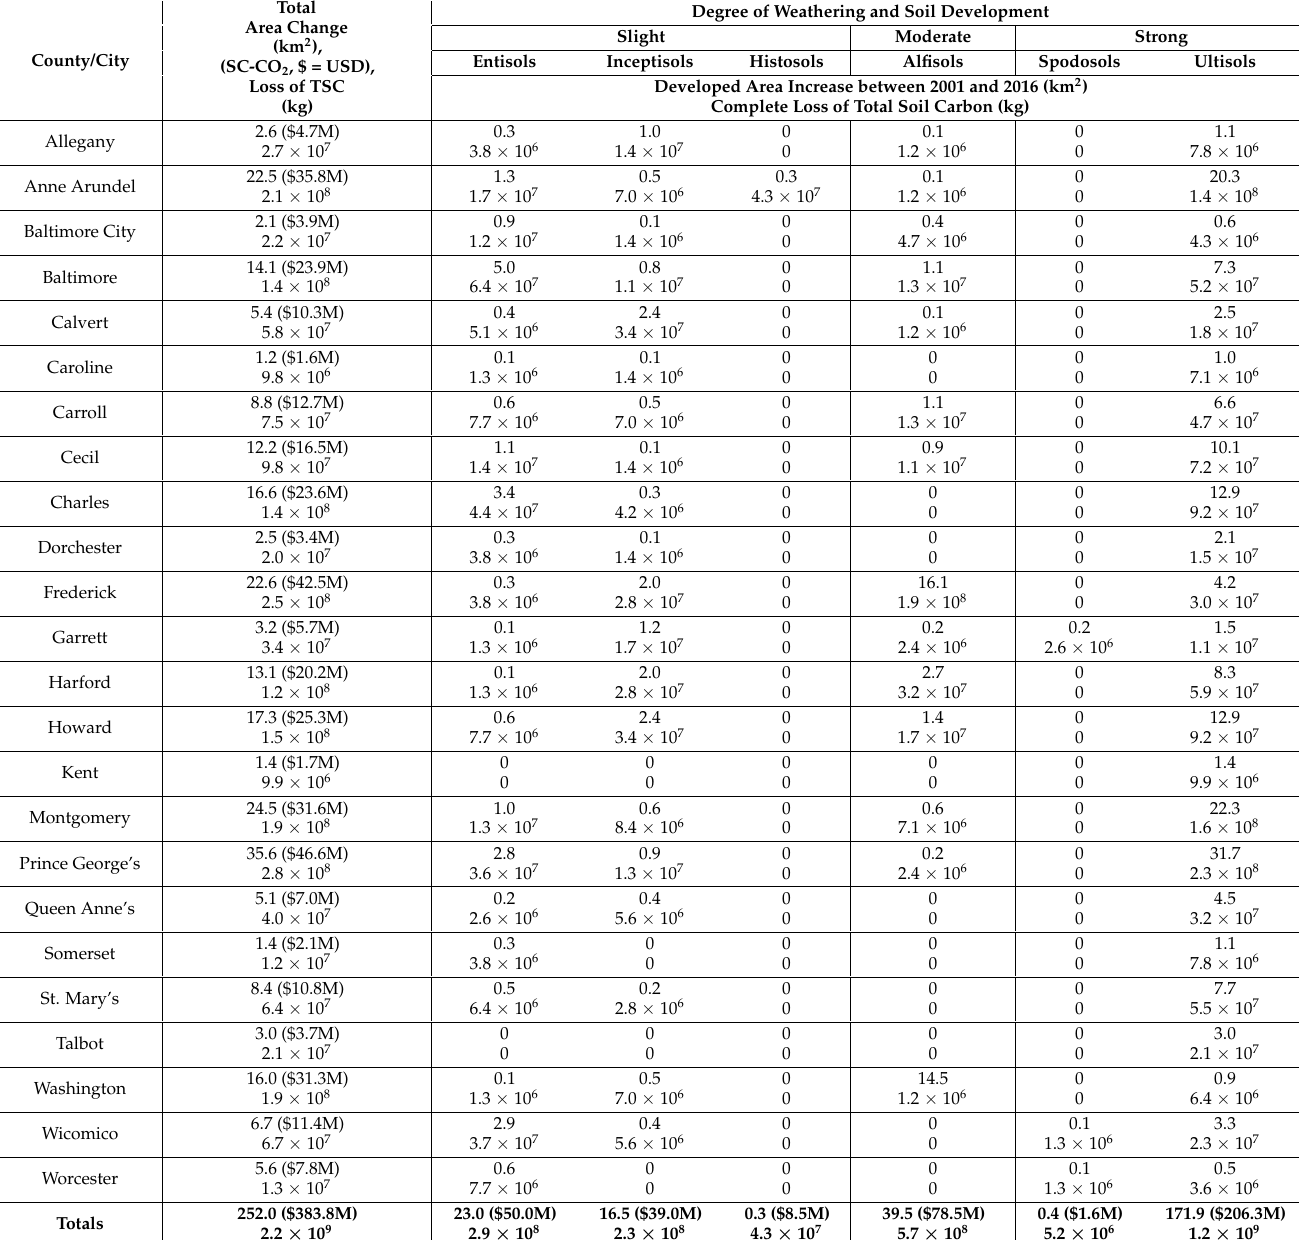
Table 8. Land development increases (landcover category: developed open space, developed medium intensity, developed low intensity, and developed high intensity), complete loss of total soil carbon (TSC) with the corresponding maximum potential realized social costs of carbon for newly developed land by county and soil order in Maryland, USA, between 2001 to